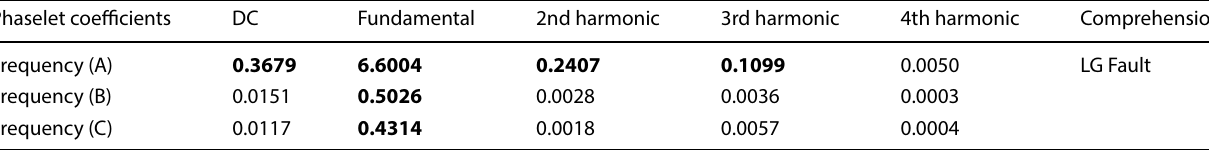
Table 2 Phaselet coefficients under lg fault